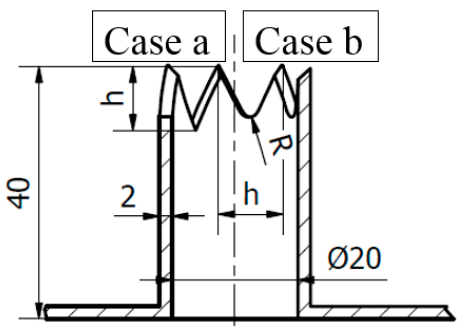
Table 1. Dimensions and parameters of SJA orifices.